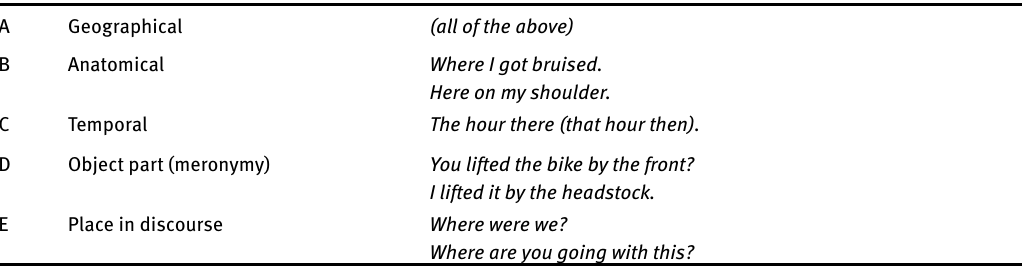
Table 2: Place Reference Metaphoric